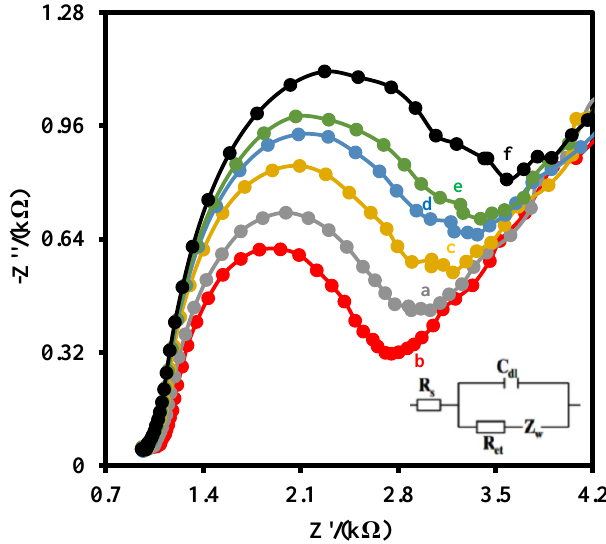
Figure 3. Nyquist plots of the EIS of the IDGE (a), IDGE/Au nano (b), IDGE/Au nano /3-MPA (c), IDGE/Au nano /3-MPA/Anti-PCT (d), IDGE/Au nano /3-MPA/Anti-PCT/BSA (e), IDGE/Au nano /3- MPA/Anti-PCT/BSA/PCT (10 pg/mL) (f) in 5 mM Fe(CN) 6 3− / 4− couple (1:1) and 0.1 M PBS. The inset is the equivalent electric circuit compatible with the Nyquist diagrams. R s : solution resistance ,R et : electron transfer resistance, C dl : double layer capacitance, Z w : Warburg impedance. AC amplitude voltage was 10 mV, DC voltage was 0 V, and frequency range was 100,000 Hz – 0.1 Hz.